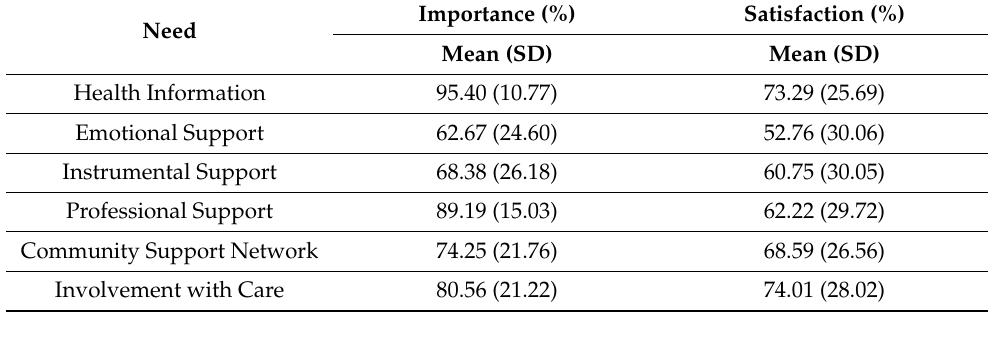
Table 3. Caregivers’ needs importance and satisfaction (FNQ).